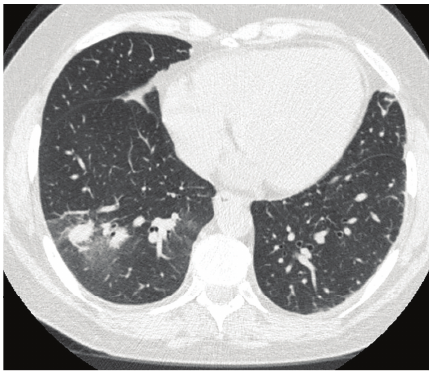
Figure 1: Chest CT scan without intravenous contrast on initial admission showing patchy infiltrates and a “halo sign” surrounding a right lower lobe